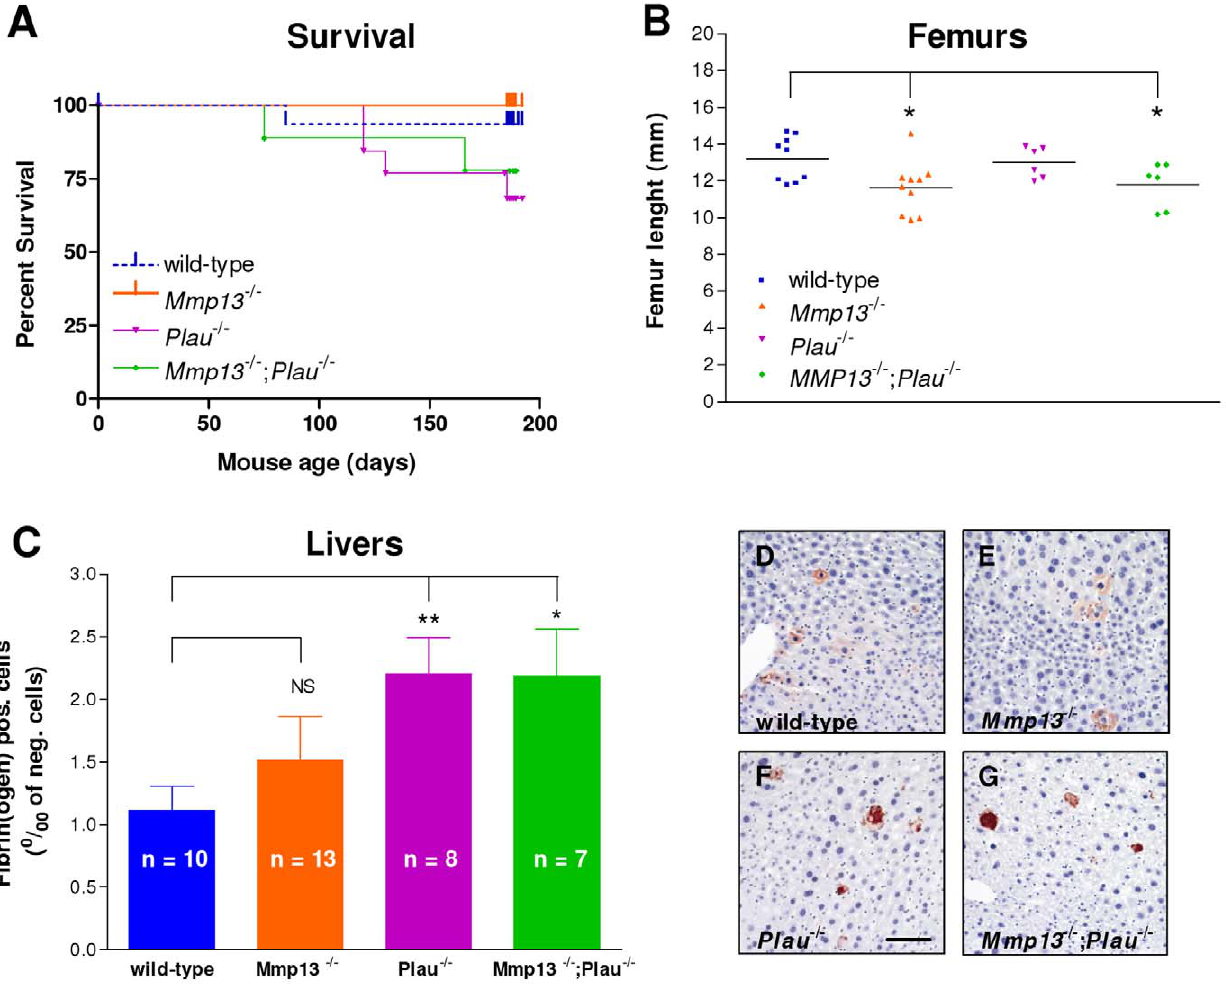
Figure 1. Survival, femur length and hepatic fibrin deposition in Mmp13;Plau double-deficient cohort mice. ( A ) Four genotype groups of siblings were selected for a survival cohort. ( B ) Femurs were removed from wild-type, Mmp13 -deficient, Plau -deficient and Mmp13;Plau double- deficient mice at six months of age. Data are represented as scatter plots and mean values are depicted as horizontal lines. ( C–G ) Livers from mice were removed when mice were six months old, processed for immunohistochemistry and stained for fibrin. ( D–G ) Scale bar =0.2 mm. ( C ) The total area of liver cells positive for fibrin per mille of liver cells negative for fibrin was quantified. Bars represent the means 6 SEM of each group. *p # 0.05; **p #